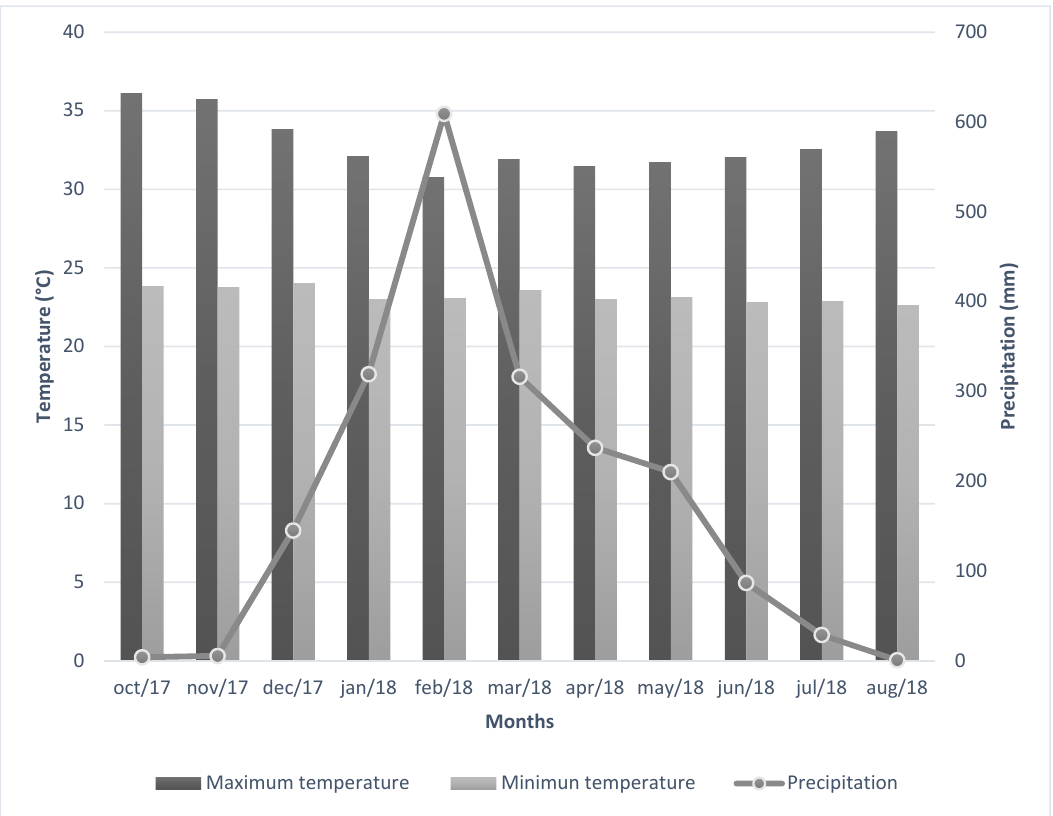
Figure 2. Precipitation, maximum and minimum temperature to the months evaluating during the study. Source: INMET, 2019 [24].